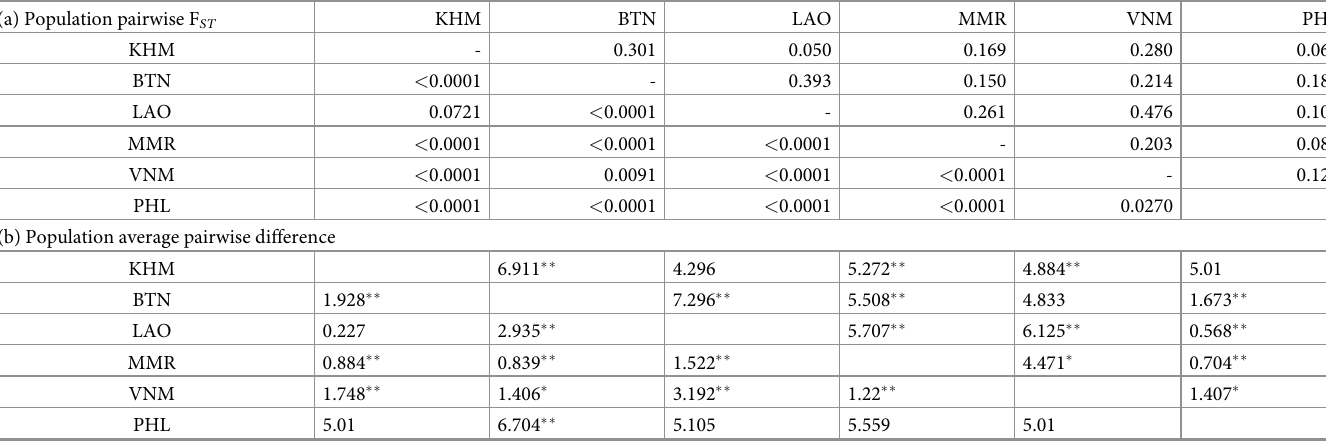
; lower triangular matrix: the p -values for the F ; (b) average ST ST